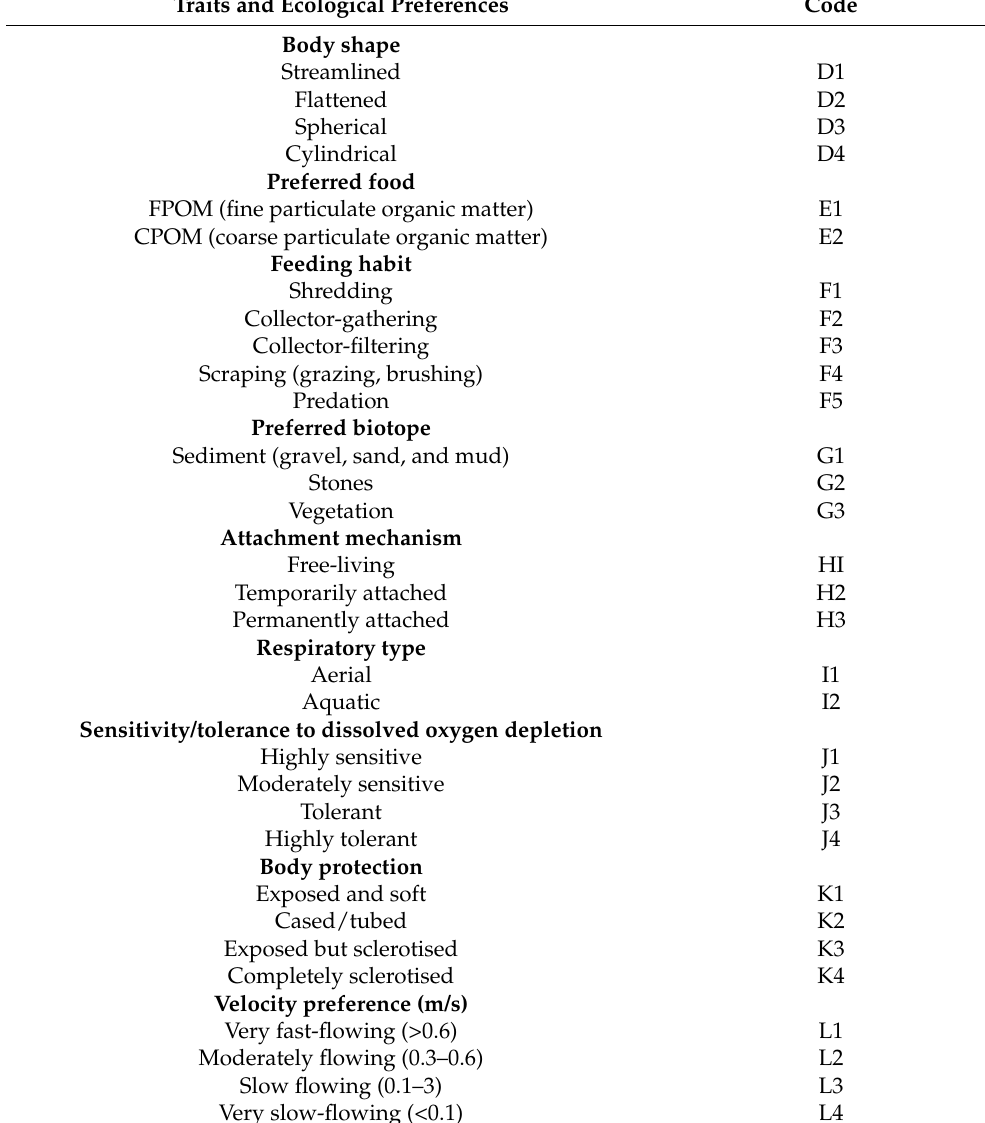
Table 1. Cont. Traits and Ecological